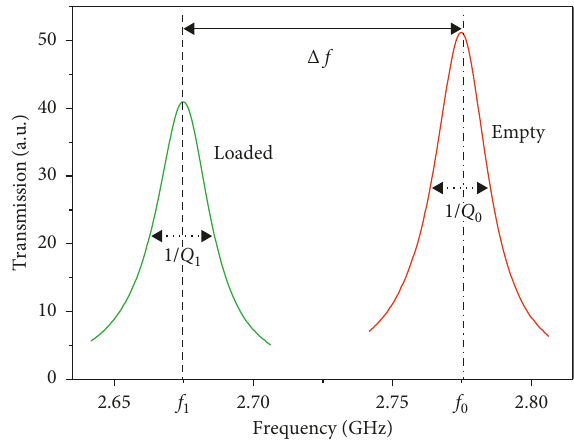
Figure 2: XRD patterns of the CCTO, PVA, and CCTO( x ) for x � 50 and